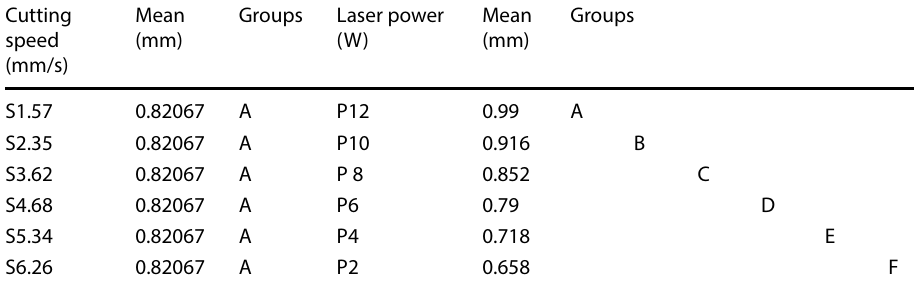
Table 26 The grouping letter table of the Bonferroni Test: Cutting speed and laser